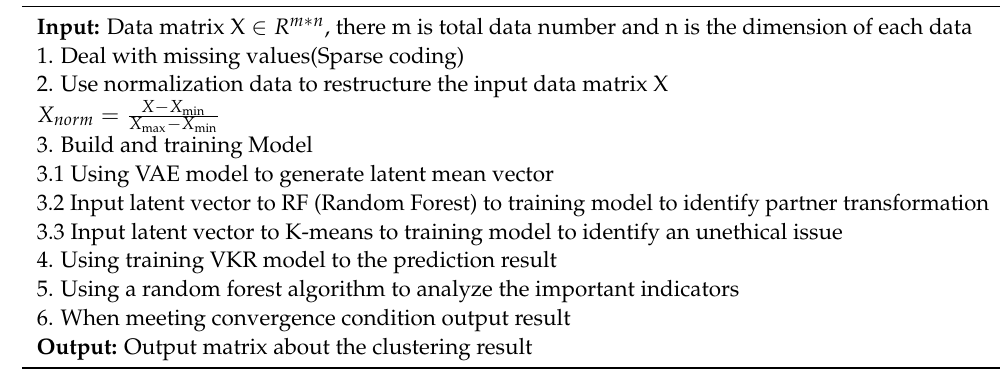
Algorithm 1: Hybrid VKR (VAE, K-means, random forest)